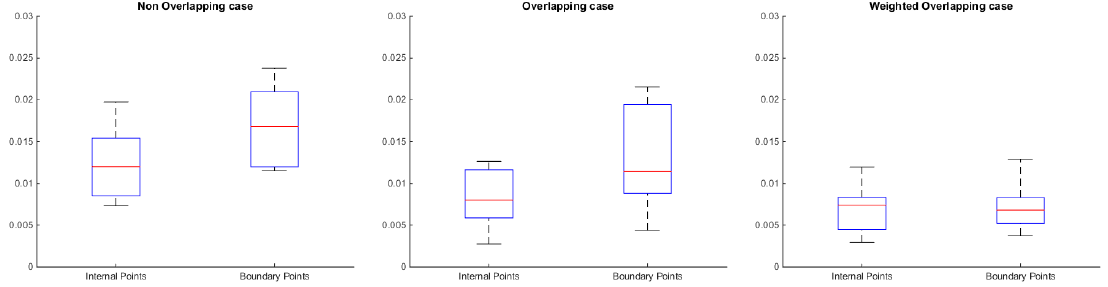
Figure 4. Standard deviation of the reconstructed error in the internal and the boundary points of each submesh for each one of the aforementioned